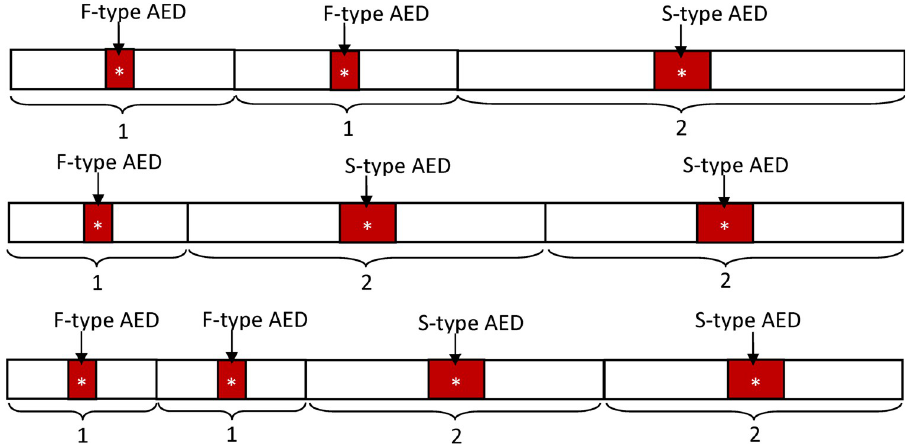
Fig 4. Illustration of optimal deployment for multiple AEDs. n (2,1), (1,2), and (2,2). Here we only indicate the hot zones of each AEDs. In the case of ( n F , n S ) = (2,1), the confined space is divided into three parts with a l-to-l-to-2 length ratio. The F-type AEDs are placed at the centers of the shorter parts, and S-type AEDs are the longer parts. Similarly, in the case of ( n F , n S ) = (1,2), the confined space is divided into three parts with a l-to-2-to-2 length ratio. In the case of ( n F , n S ) = (2,2), four parts are needed with a length ratio of 1-to-1-to-2-to-2.